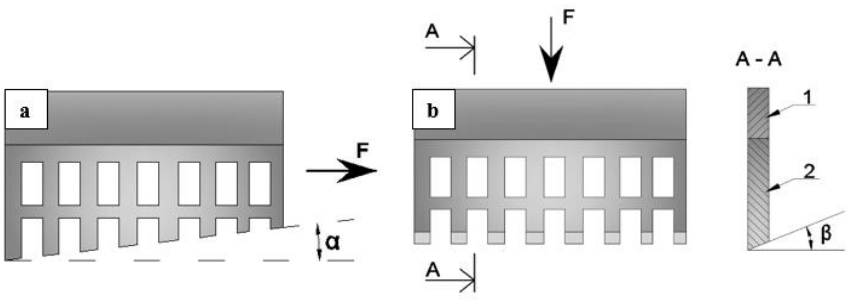
Figure 21. Single-layer cutting element with inclined teeth made of perforated steel strip: for horizontal ( a ) and vertical cutting ( b ) (F—pulling force, 1—gripper, 2—cutting blade).